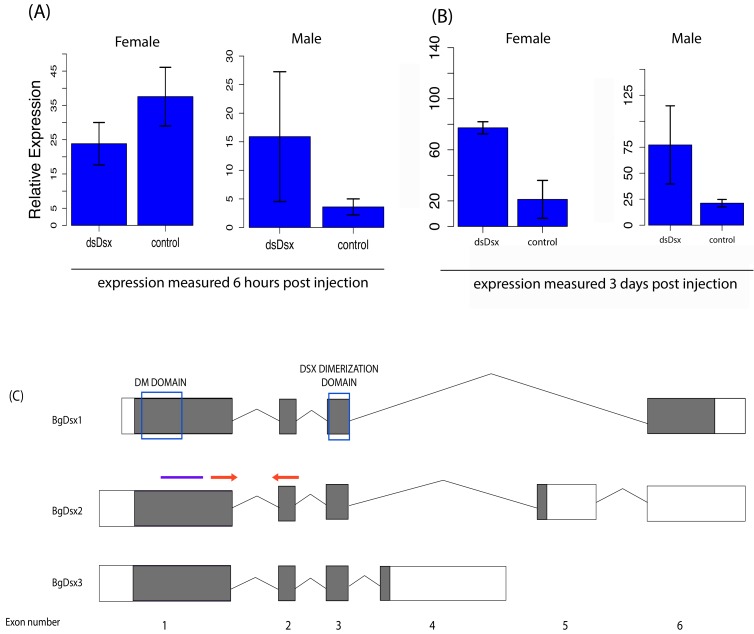
BgDsx RNAi causes an increase in BgDsx transcript abundance in both males and females of Blattella germanica.BgDsx expression was measured (A) 6 hr and (B) 3 days after injection with dsRNA targeting the BgDsx common region. (C) qPCR primers (red arrows) were located outside the region targeted by dsBgDsx (purple bar). n = 3 females and three males per treatment. Expression levels of BgDsx are normalized to β-actin.